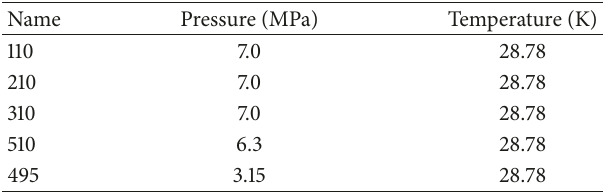
Table 5: Record of pressures and temperatures for time-dependent volumes.